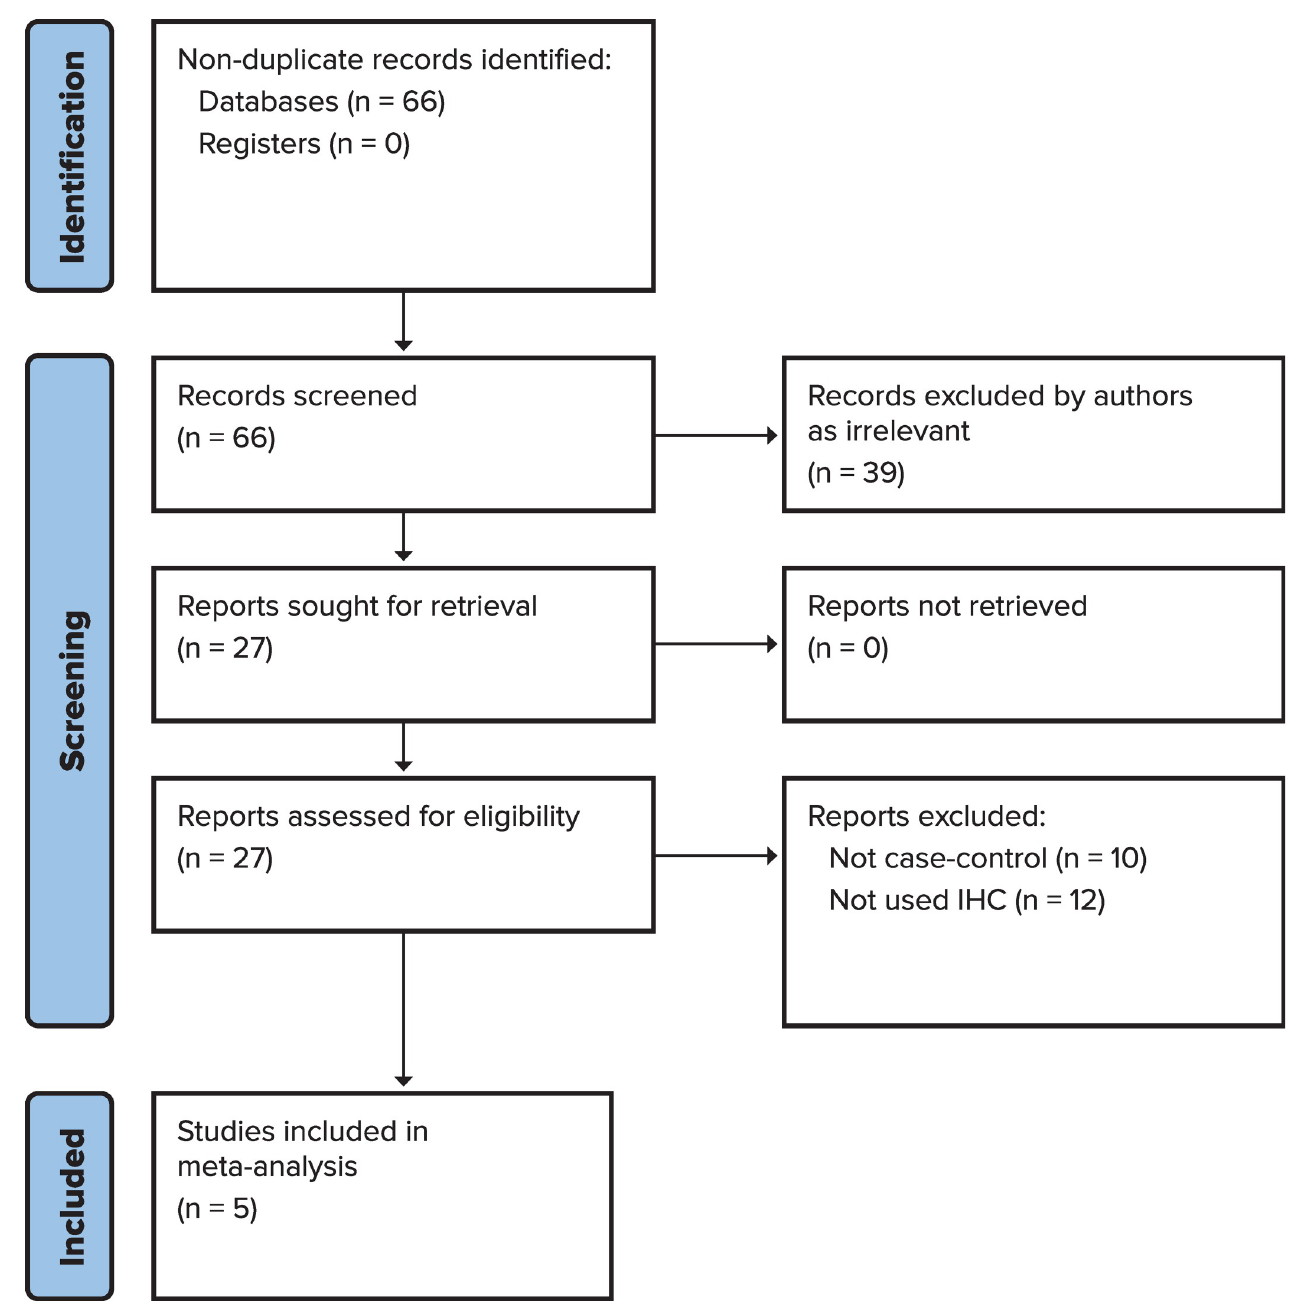
Fig 1. The PRISMA flow chart of study